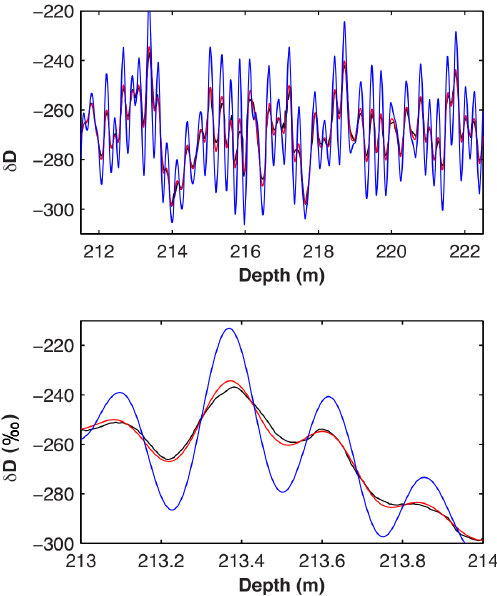
Figure 5. A comparison of the WAIS Divide ice core δ D signal measured on the CRDS-CFA system (black); the CRDS-CFA mix- ing corrected isotopic signal using σ mockice of 0.8cm (red); and a correction for a typical West Antarctic diffusion value of 6.5cm (blue), which represents diffusional processes occurring naturally in the ice sheet (see Fig. 6 of Cuffey and Steig, 1998). The mix- ing introduced by the CRDS-CFA is only a fraction of the diffusion occurring naturally in the ice